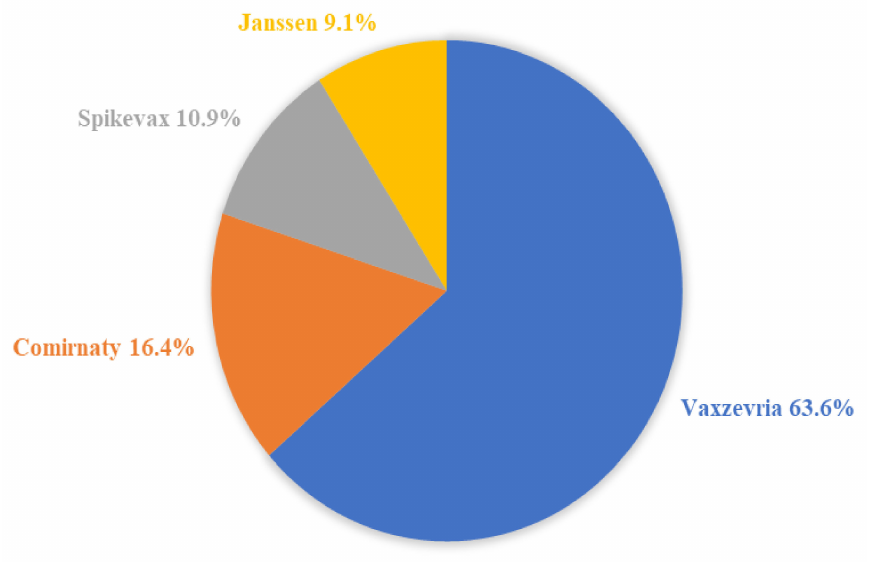
Figure 3. The distribution of the type of vaccine among the 55 cases of death after the